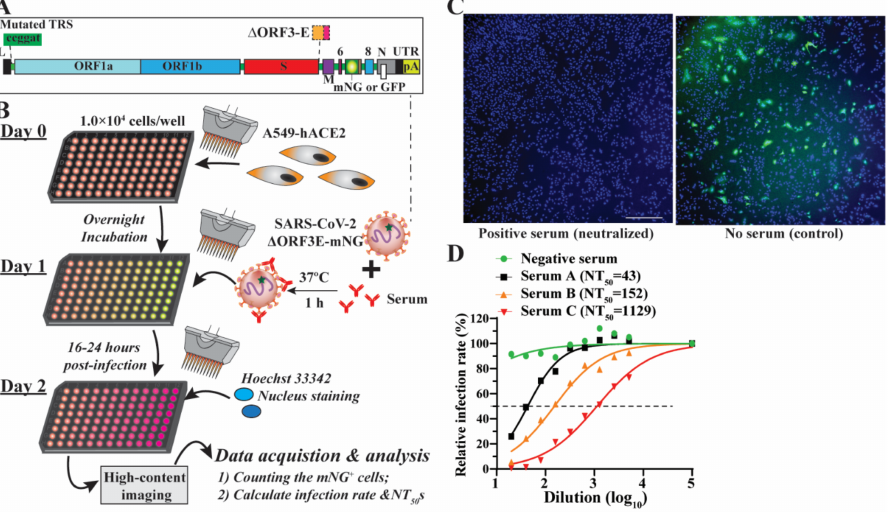
Figure 1. Rationale and workflow of the SFVNT assay. ( A ) The genome architecture of SFV. TRS, transcription regulation sequence; L, leader sequence; ORF, open reading frame; S, spike